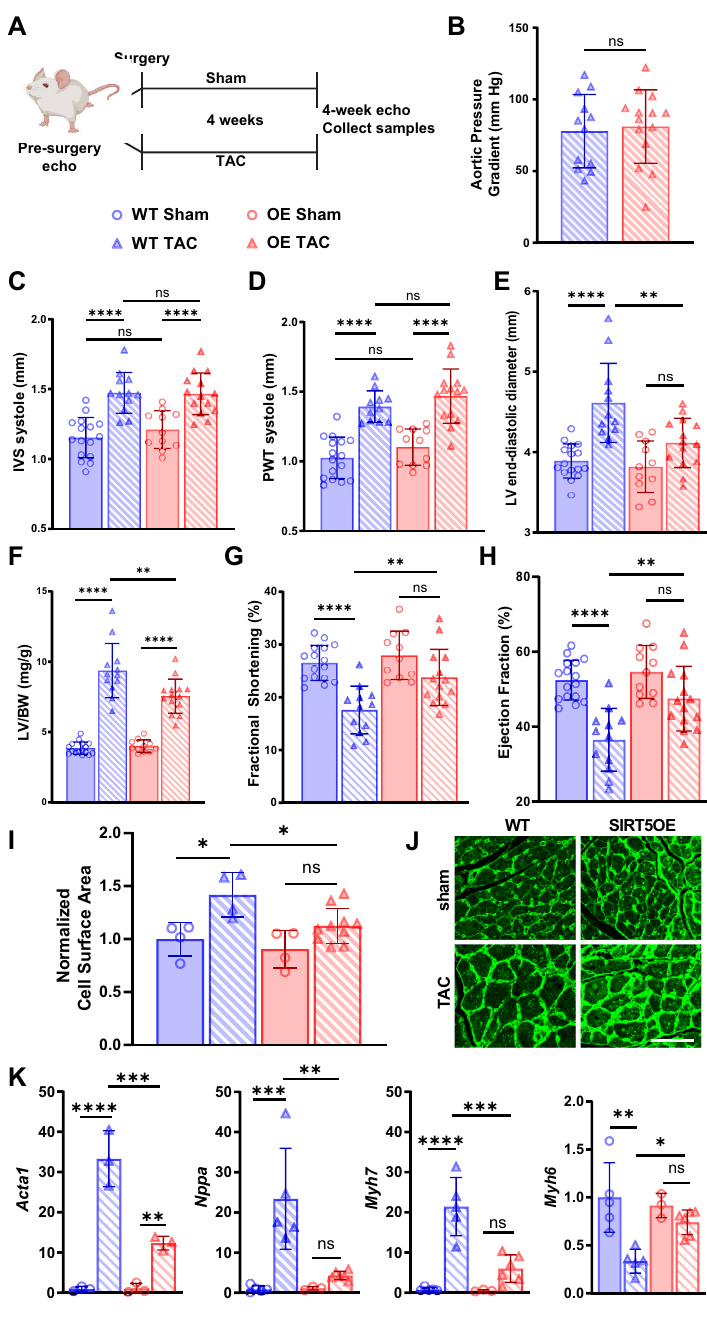
Figure 2. SIRT5OE mice are protected against TAC-induced heart failure. Echocardiography was performed on WT sham ( n = 16), WT TAC ( n = 12), SIRT5OE sham ( n = 10) and SIRT5OE TAC (n = 14) mice to measure changes in cardiac function four weeks post-surgery. (A) Depiction of groups, procedures, and timeline of surgery. (B) Aortic pressure gradient in mice after TAC. Echo measurements for (C) systolic interventricular septum (IVS) thickness; (D) systolic posterior wall thickness (PWT); (E) LV end-diastolic diameter; (F) left ventricle mass normalized to body weight; (G) fractional shortening; (H) ejection fraction. (I) Quantification of CM cell area, normalized to WT sham four weeks after surgery [WT sham ( n = 4), WT TAC ( n = 4), SIRT5OE sham ( n = 4) and SIRT5OE TAC ( n = 10)]. (J) Representative wheat germ agglutinin-stained cardiac sections of the indicated genotypes and treatments four weeks post-surgery. Scale bar = 50 um. (K) qRT-PCR for Acta1 (n = 3 for all groups); Nppa and Myh6 [WT sham ( n = 5), WT TAC ( n = 5), SIRT5OE sham ( n = 3) and SIRT5OE TAC ( n = 6)]; and Myh7 [WT sham ( n = 5), WT TAC ( n = 4), SIRT5OE sham ( n = 3) and SIRT5OE TAC ( n = 5)] expression normalized to GAPDH. Statistical significance was determined using Student’s t-test for 2-group analysis or two-way ANOVA followed by Sidak’s correction for multiple comparisons for 4-group